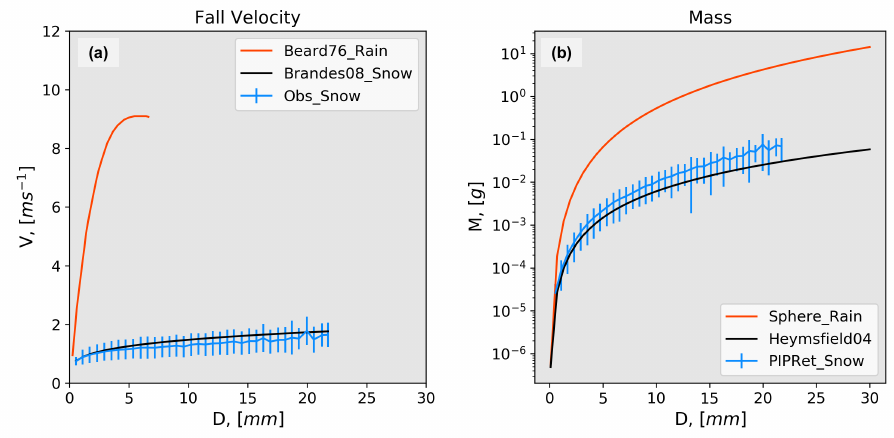
Figure 6. Fall speed and mass diameter relations for rain and snow. ( a ) Particle fall velocity for rain (red) determined by the empirical relation from [45]. Mean (blue centerline) and one standard deviation (blue bars) particle fall velocity for snow measured by the PIP and the predicted fall velocity at − 1 ◦ C from [81] (black). ( b ) Particle mass for rain (red) determined by assuming a spherical shape. Particle mass for snow as retrieved from the PIP and predicted by the relation in